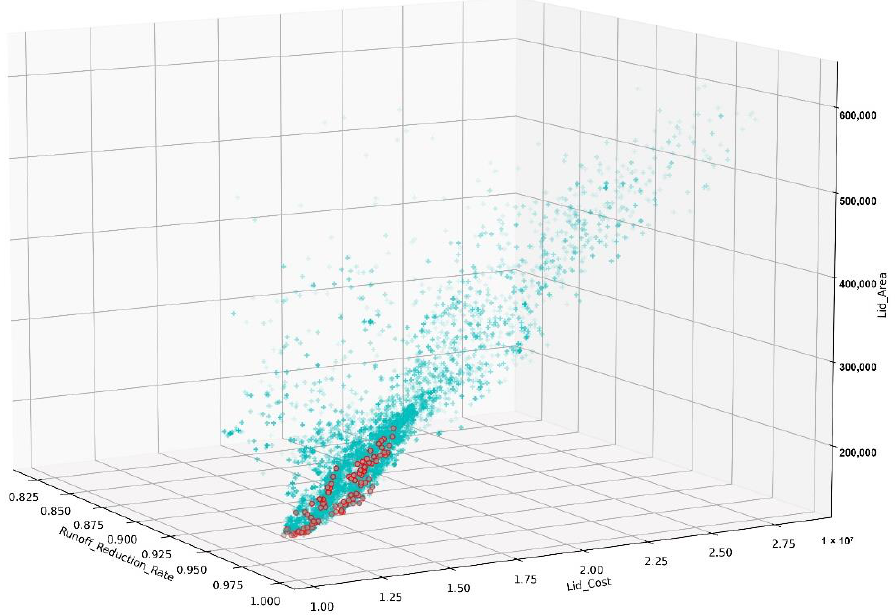
Figure 7. Genetic algorithm optimization results.